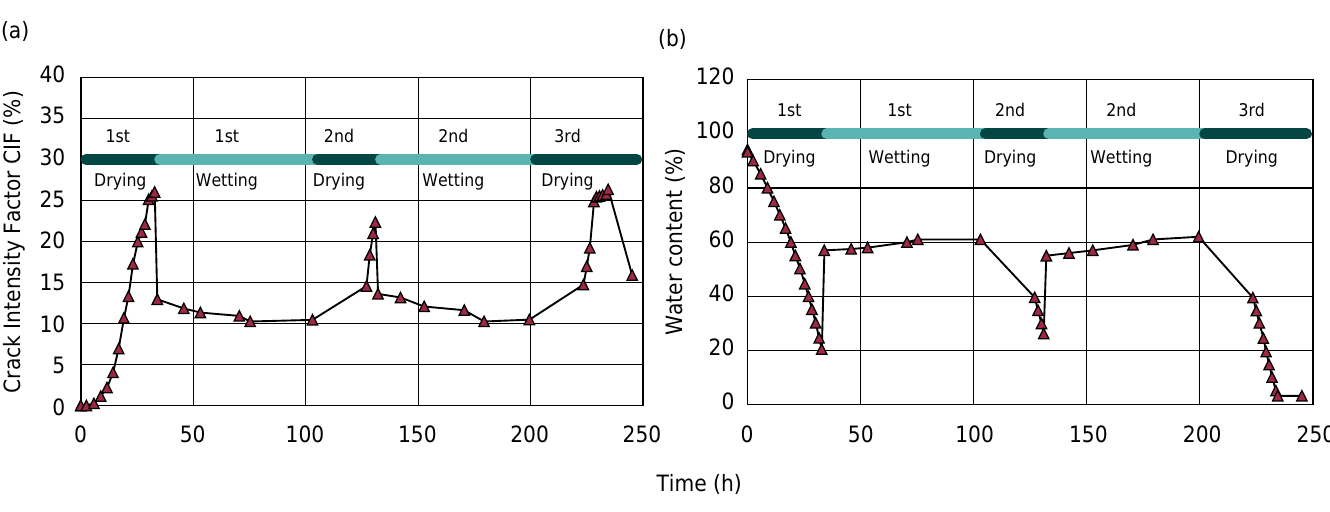
Figure 6. Variation of the Crack Intensity Factor and Water content with Time (a) CIF vs Time, (b) Water content vs